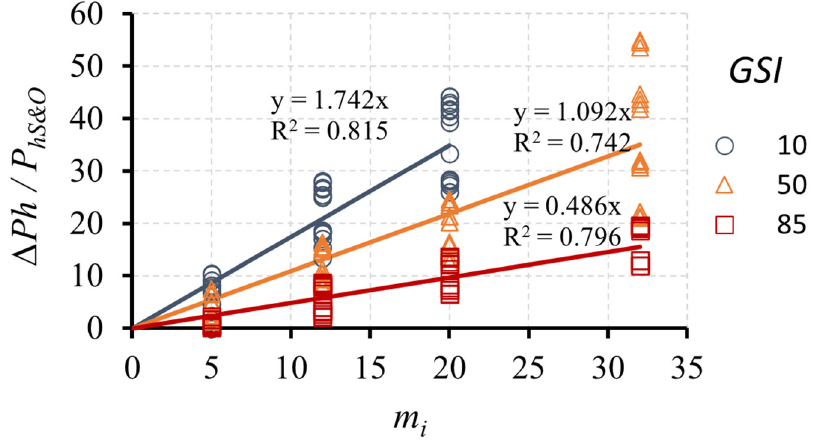
Figure 8. Relation between ∆ P h /P hS&O depending on m i , for different values of GSI . Table 3. Equations ∆ P h /P hS&O depending on m i , for different values of GSI .